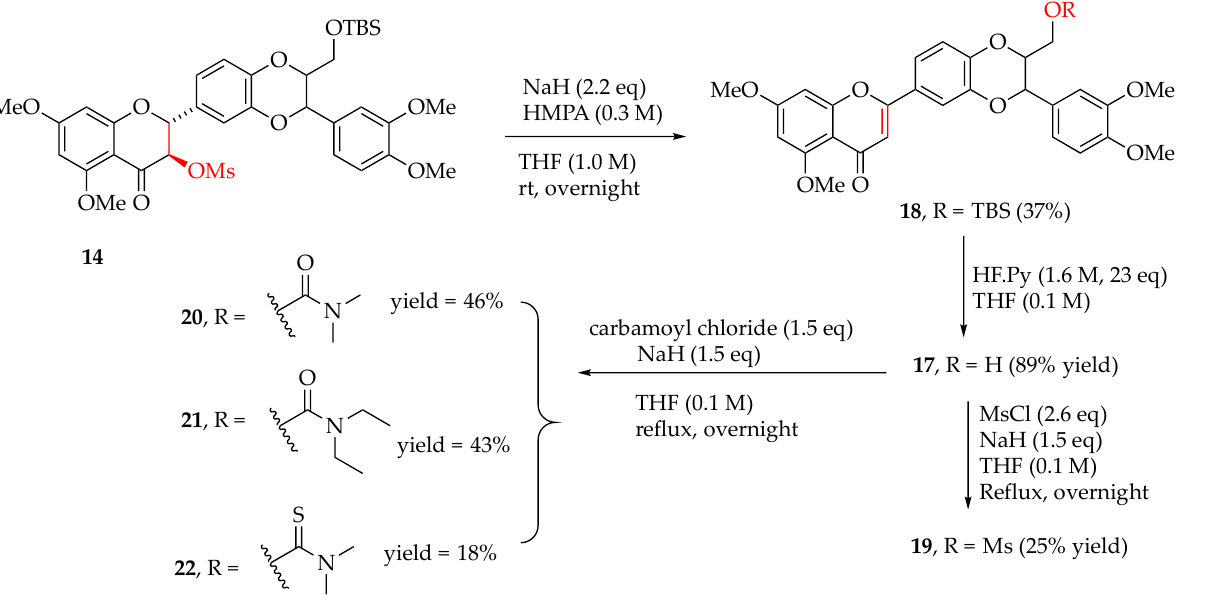
Scheme 2. Synthesis of 5,7,20- O -trimethylhydnocarpin Ds 17 – 22 . Structurally, hydnocarpin D ( 2 ) differs from silybinin in ring C due to the absence of 3-OH and the presence of a double bond between C-2 and C-3. The chemical structure of 5,7,20- O -trimethylhydnocarpin D ( 17 ) was characterized by its NMR and HRMS. The 1 H NMR signal at 4.92 ppm for H-2 of 5,7,20- O -trimethylsilybin ( 5 ) disappeared, and the H-3 signal was downshifted from 4.42 ppm for 5,7,20- O -trimethylsilybin ( 5 ) to 6.61